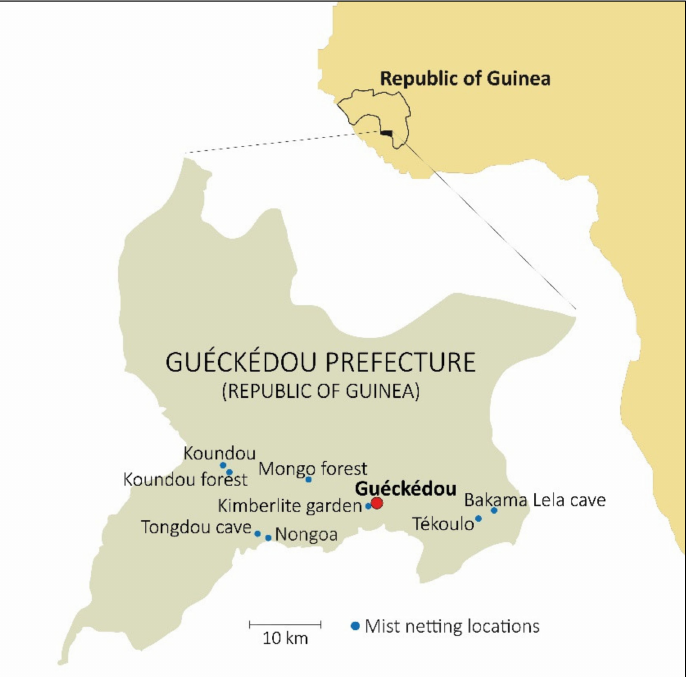
Figure 1. Locations of the bat sampling sites. Bats were sampled in eight locations in the Gu é ck é dou prefecture: Gu é ck é dou (Kimberlite garden), T é koulo (T é koulo village and Bakama Lela cave), Temes- sadou (Mongo forest), Nongoa (Nongoa village and Tongdou cave), and Koundou-Lengobengou (Koundou village and Koundou